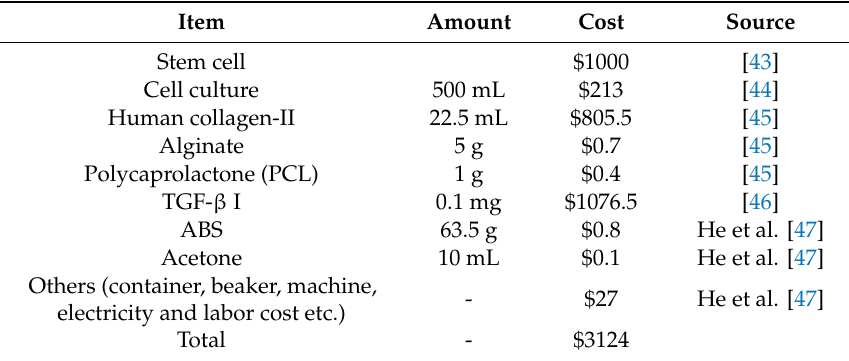
Table 3. List of 3D-printed meniscus implant